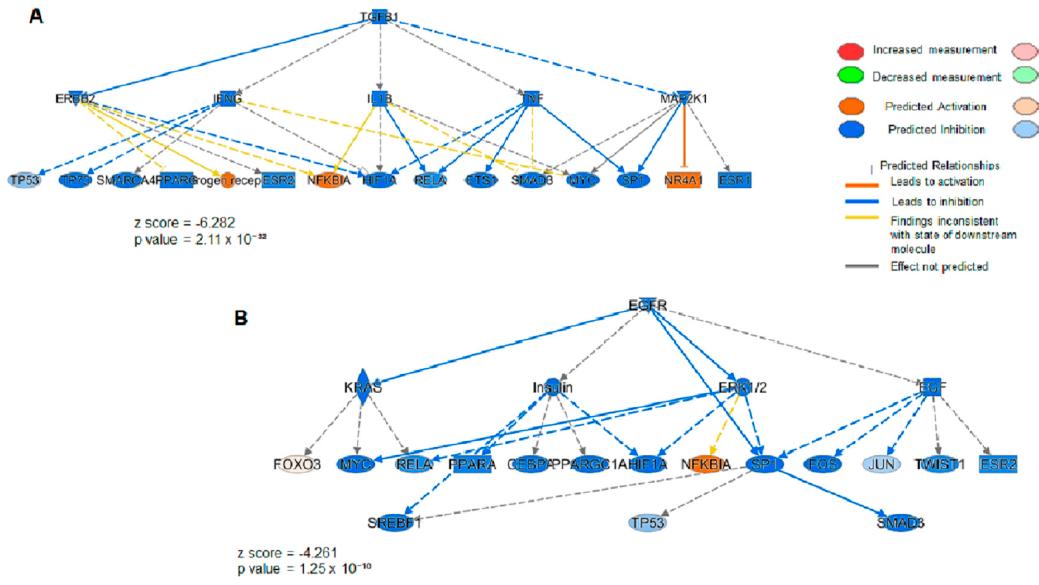
Figure 3. Upstream network analysis of the proteins from endothelial cells exposed to ponatinib and Notch-1 signaling inhibition. Upstream inhibited in HUVECs treated with ponatinib compared to those co-treated with ponatinib and anti-Notch-1 antibody. Panel ( A , B ), image shows the upstream activation of NF-kappa-B inhibitor alpha (NFKBIA) gene resulting in a z-score of 2.546, and the upstream inhibition of Transforming Growth Factor-Beta1 (TGFB1) gene ( A ) and Epidermal Growth Factor Receptor (EGFR) gene ( B ) resulting in a z-score of − 6.282 and − 4.261, respectively. Blue color key indicates inhibited regulators, while the orange one indicates the activated regulators. The intensity of the color is proportional to the score prediction value. As reported previously, z-scores > 2.0 indicate that a molecule and / or function is activated, whereas z-scores < − 2.0 indicate the inhibition of the